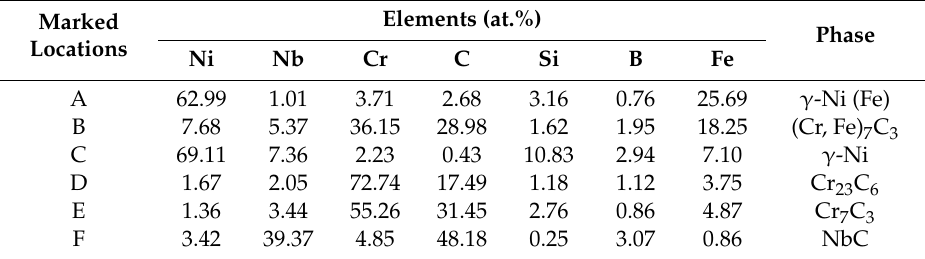
Table 4. EDS results.